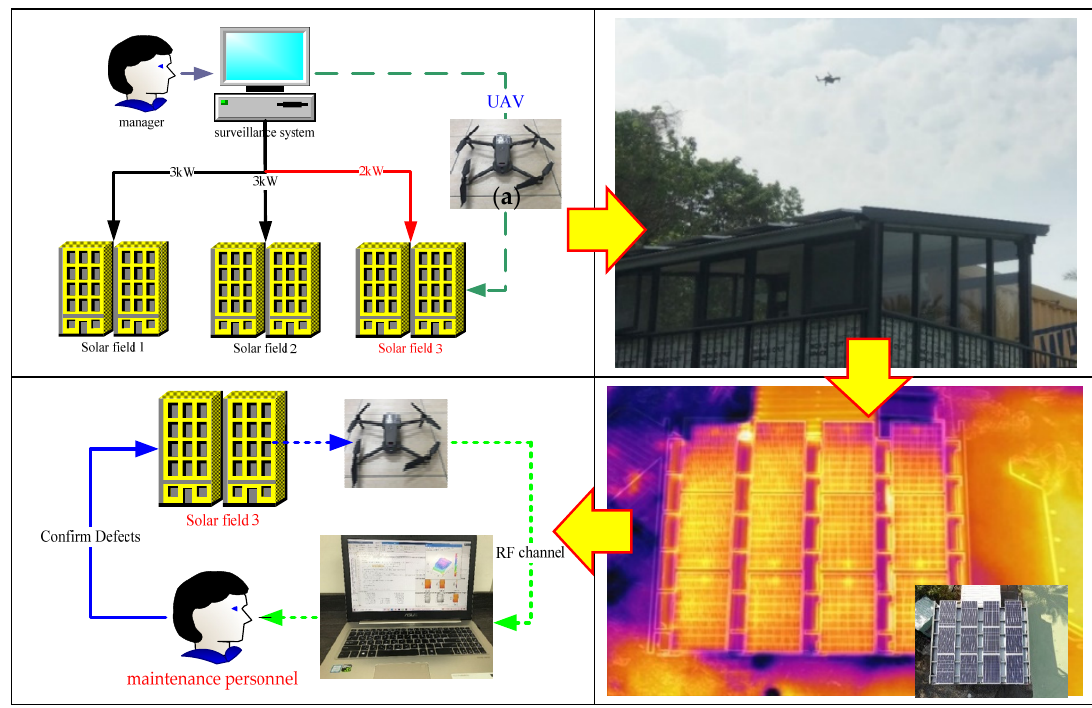
Figure 3 . Flight mission planning - CYUT Solar Photovoltaic Experimental Field. Figure 3. Flight mission planning—CYUT solar photovoltaic experimental